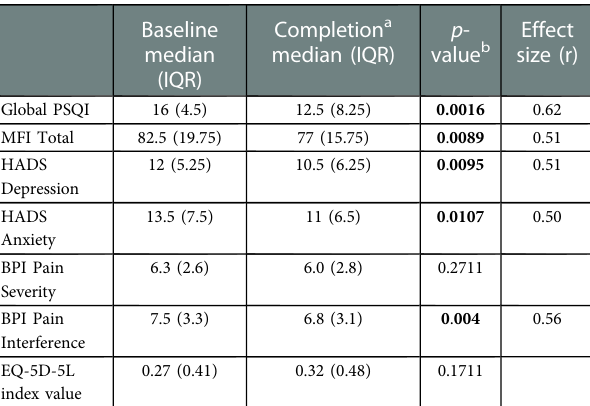
TABLE 3 Actigraphy results (n=24). Mean (SD) at Baseline Mean (SD) in hBET (165 nights) condition (538 nights)